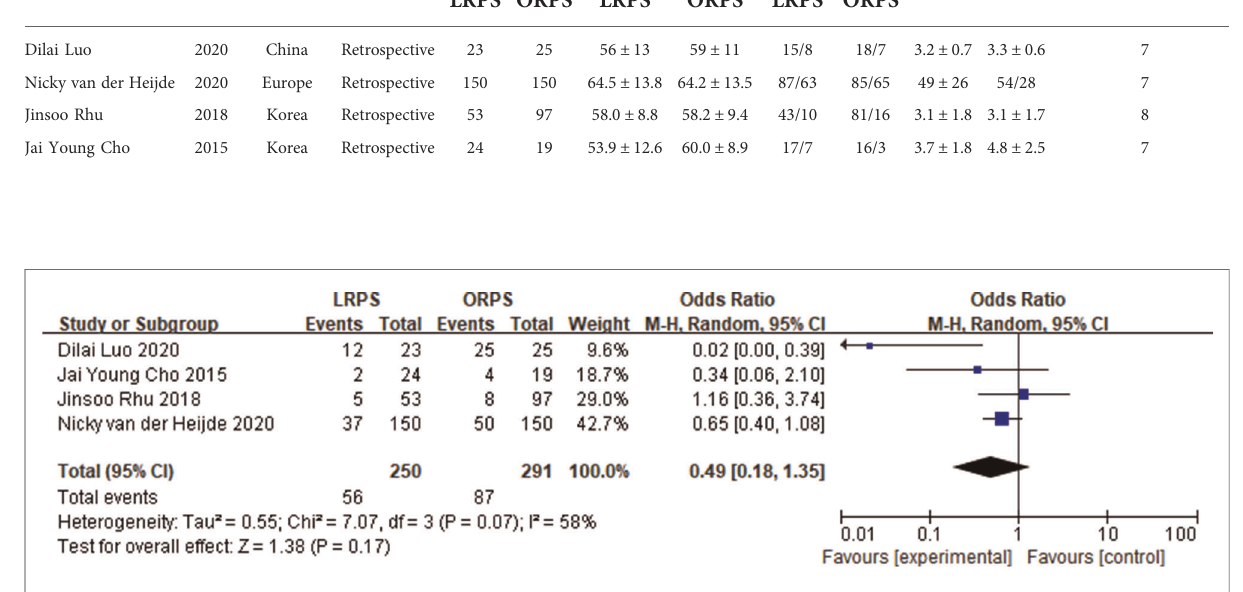
FIGURE 1 Pooled meta-analysis of postoperative complications comparing laparoscopic right posterior sectionectomy (LRPS) with open right posterior sectionectomy (ORPS).